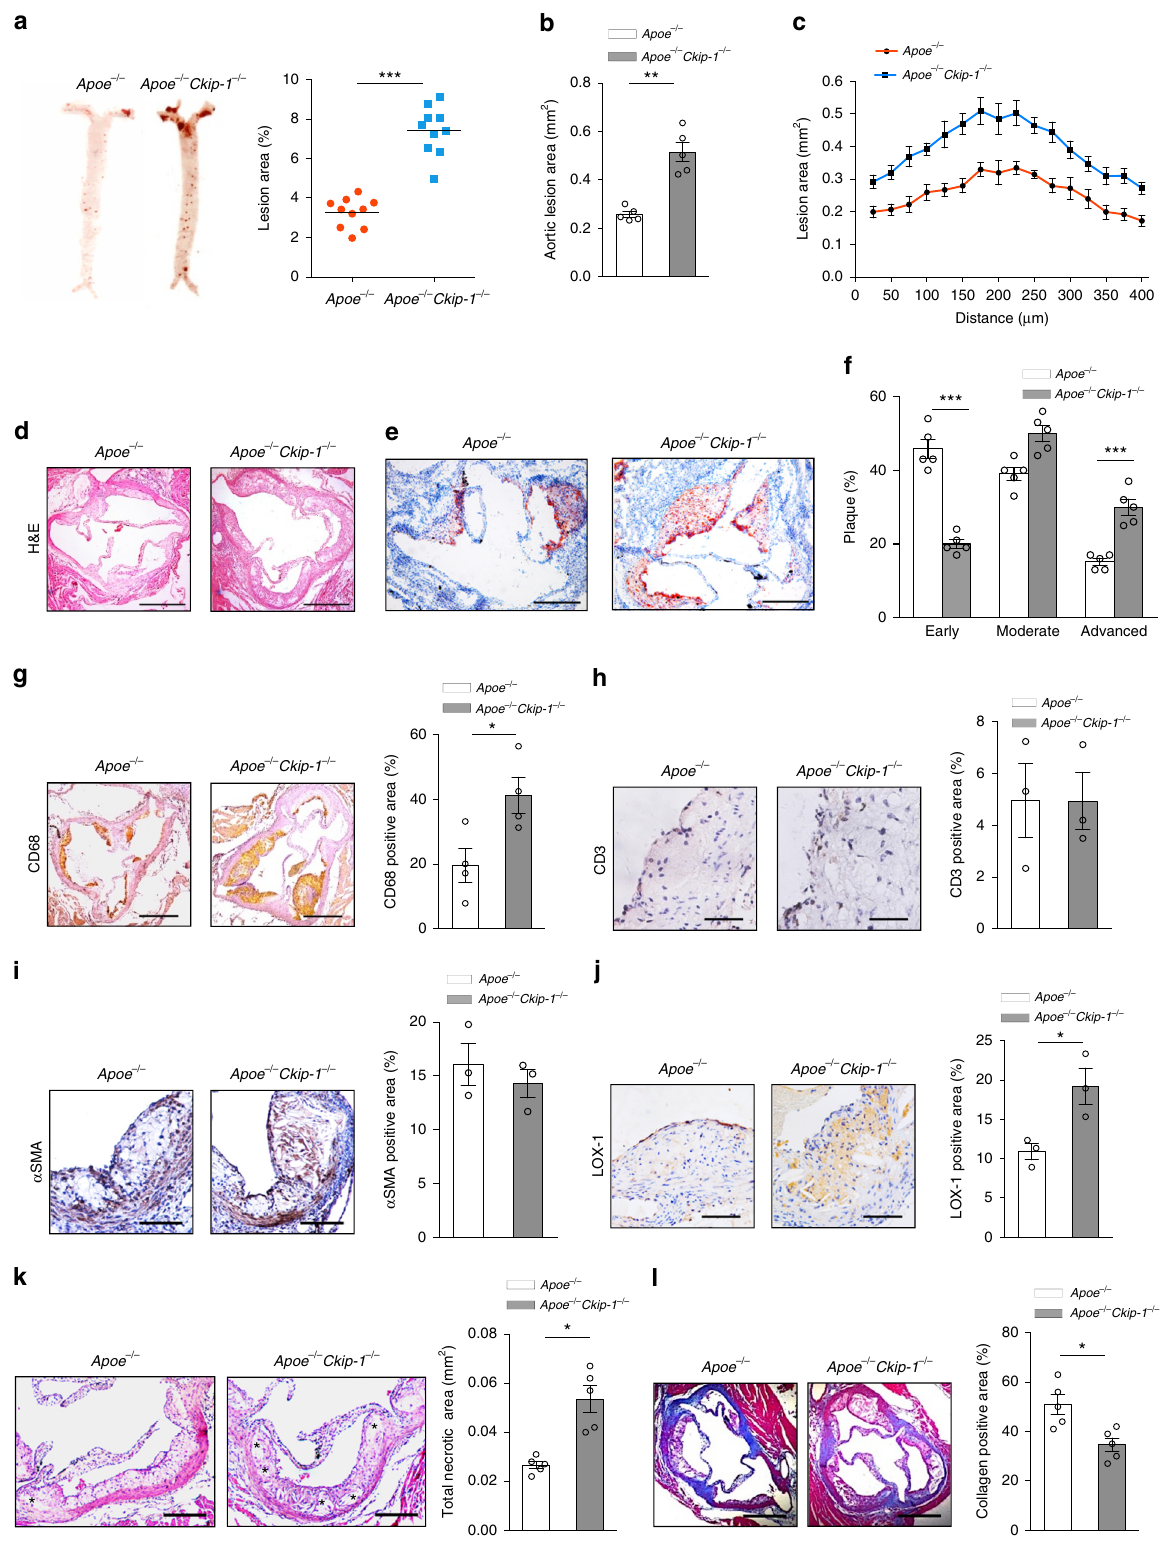
(Supplementary Fig. 4d). The expression of scavenger receptor LOX-1 was upregulated in peritoneal macrophages from Western diet-fed Apoe − / − Ckip-1 − / − mice (Supplementary Fig. 4e). Furthermore, the expression of LOX-1 in atherosclerotic lesions